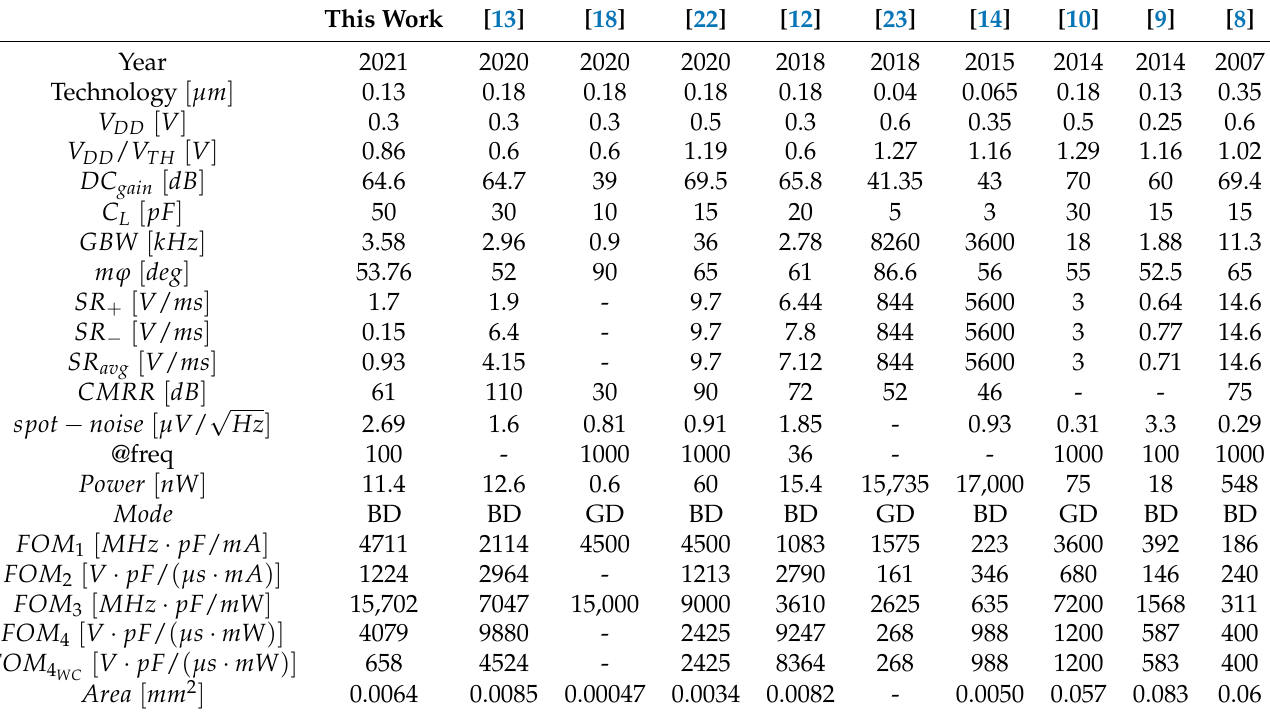
Table 6. Comparison with ultralow voltage (ULV) state of the art